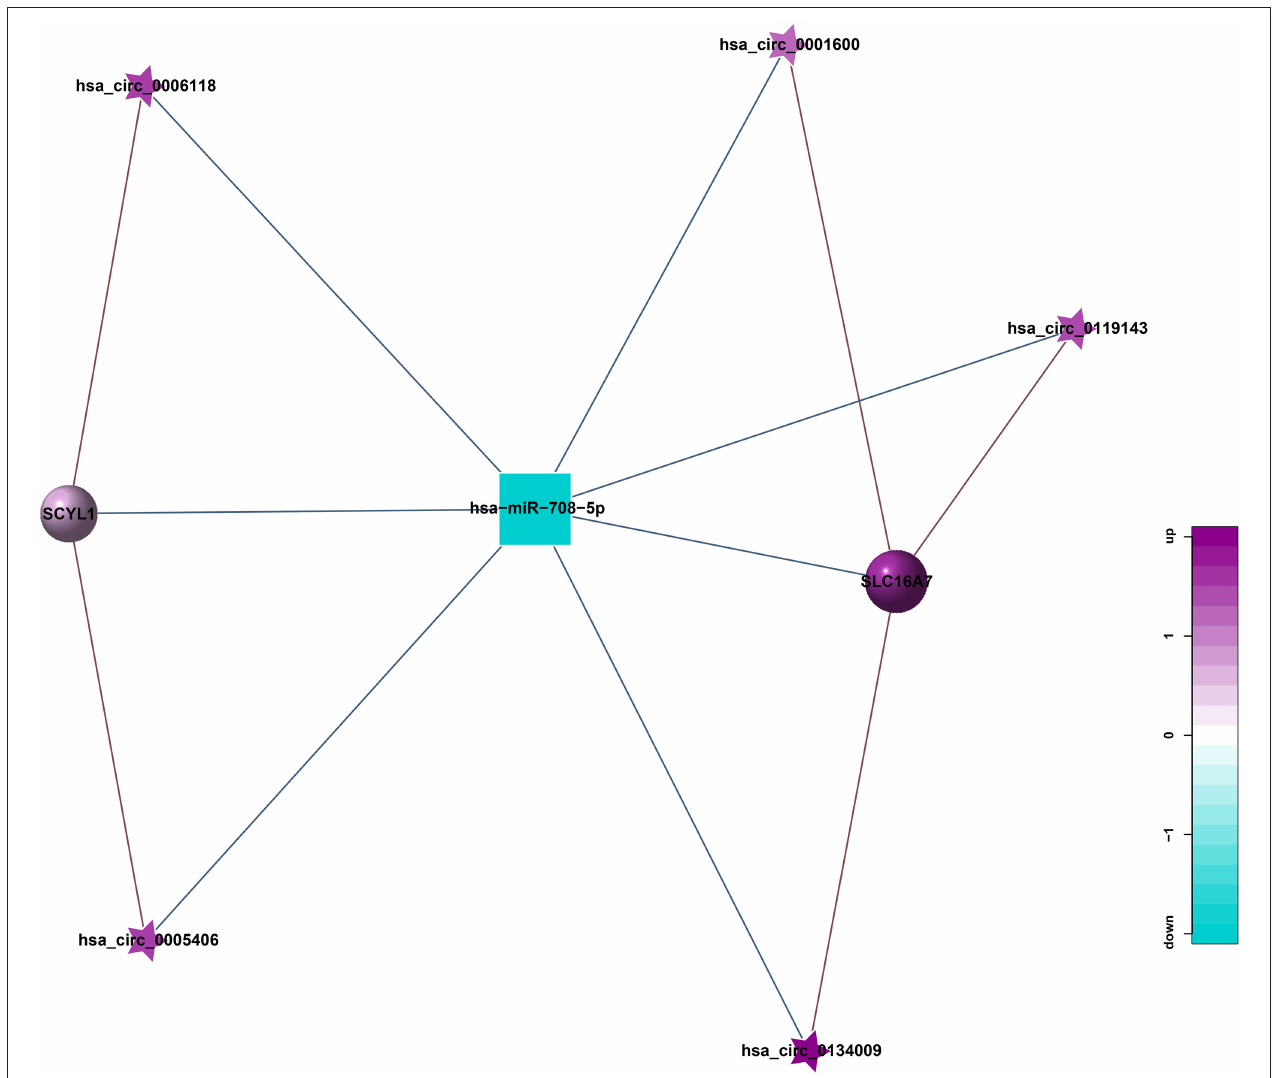
FIGURE 9 | circRNA-miRNA-mRNA regulatory network related to HT (Pentagram: circRNA; Square: miRNA; Circle: mRNA; Blue: down-regulation; Purple: up-regulation).